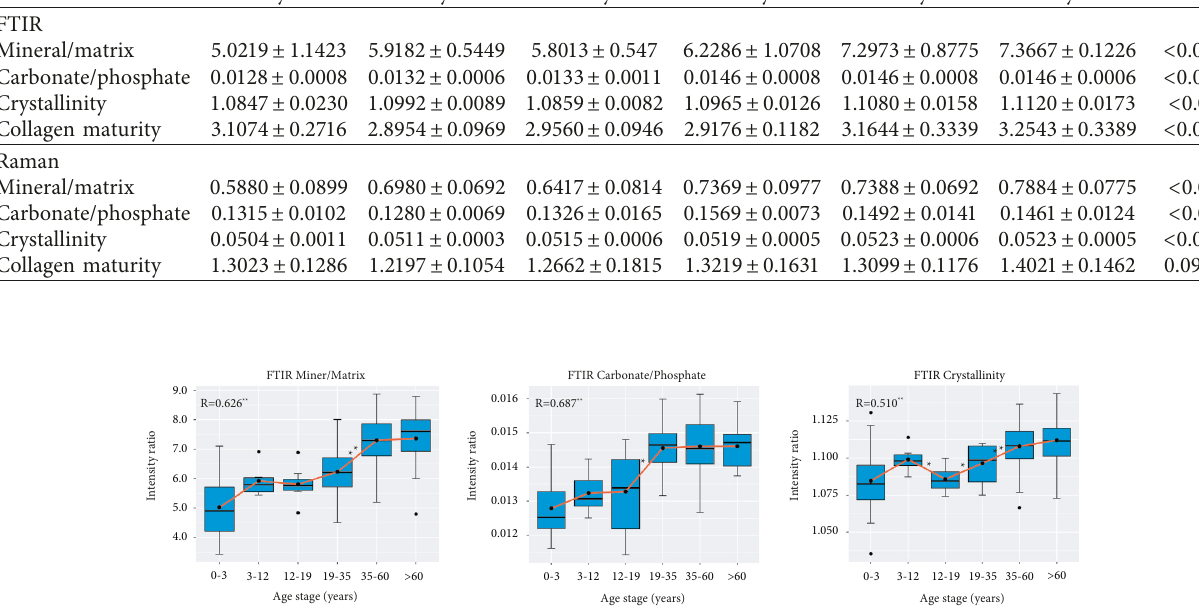
SD. The results of Kruskal–Wallis ∗ ±